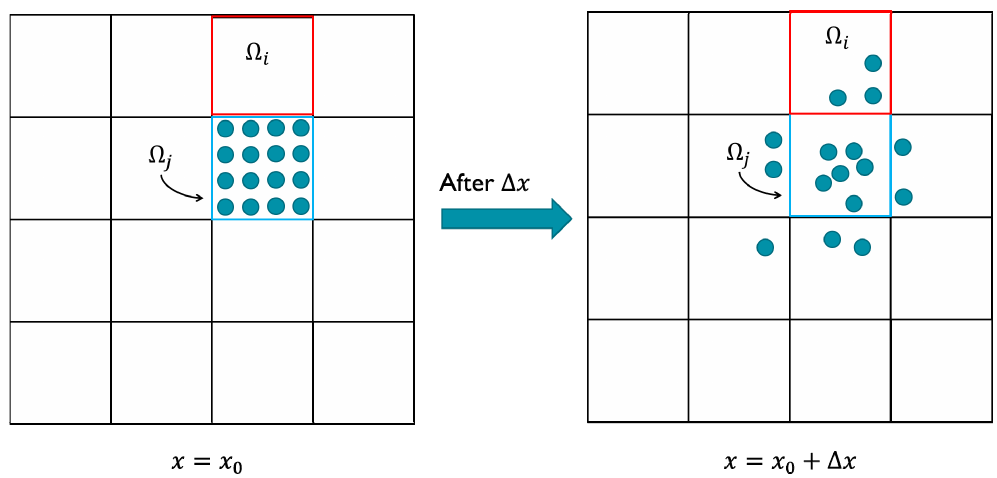
Figure 1. The calculation of the mapping coefficient Φ ij in the mapping matrix is the ratio of the number of markers received by the recipient cell Ω i at X = X 0 + Δ X to the initial number of markers in Ω j at X = X 0 (in this example Φ ij = 3 /16) [26,27].